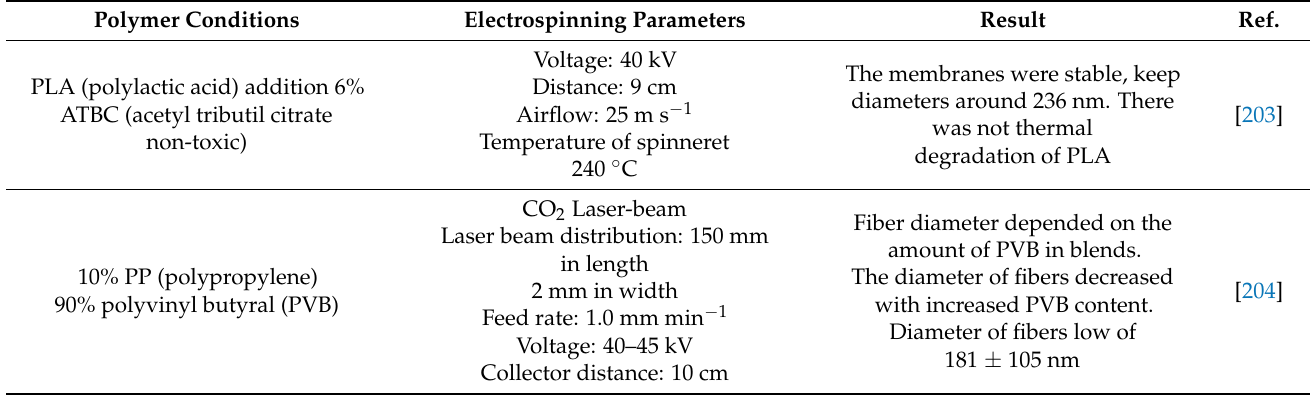
Figure 16. ( a ) CO 2 Laser system for obtained fiber PP/PVB by Melt Electrospinning. SEM images of PP fibers from: ( b ) PVB-10%; ( c ) PVB-20%; ( d ) PVB-30%; ( e ) PVB-40%; and ( f ) PVB-50%. Reprinted with permission from Ref. [204]. Table 2. Melt electrospinning for the development of nanofiber